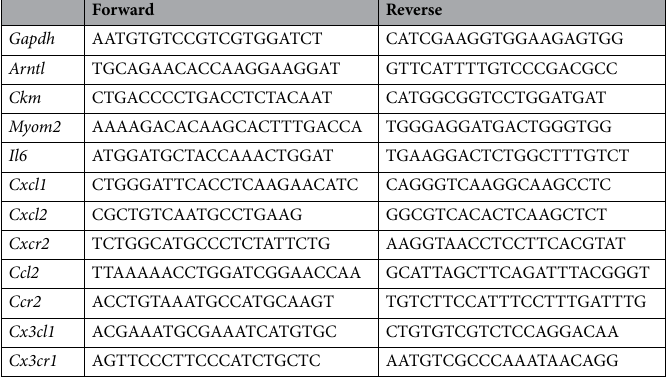
Bone marrow-derived macrophages and peritoneal macrophages. To culture bone marrow- derived macrophages, bone marrow was collected from mice by perfusing the medullary cavities of the femur and tibia and suspended in red blood cell lysis buffer. The cells were then cultured in RPMI-1640 medium con- taining 10% FBS and 45 ng/ml M-CSF (BioLegend) in 15 cm Petri dishes. The medium was changed after 3 days, and the cells were collected on day 5 of differentiation. To prepare peritoneal macrophages, cells were collected from the peritoneum of mice in exudate after peritoneal lavage. The collected cells were cultured for 1 h, then washed with PBS to remove nonadherent cells. The adherent cells were cultured as macrophages overnight 65 . Some of the macrophages were stimulated for 6 h with the specific TLR4 agonist Kdo2-lipid A (KLA, 100 ng/ ml, Sigma-Aldrich, St. Louis, MO, USA) 66 . Untreated or stimulated macrophages were subsequently harvested